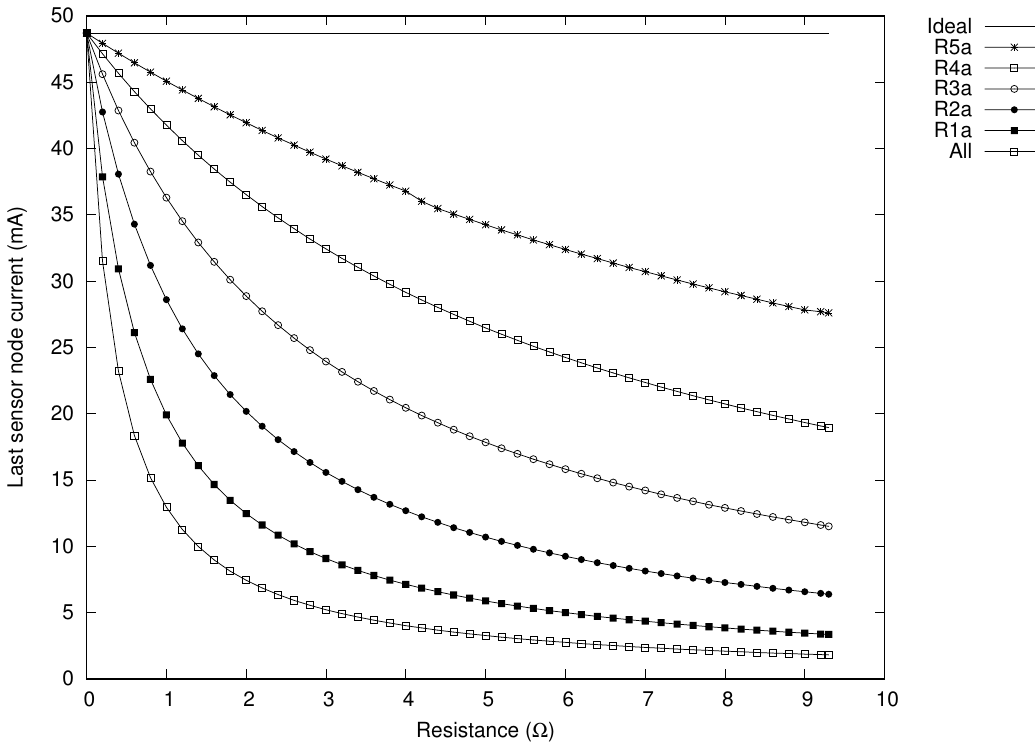
Figure 6. Simulation results of the last sensor node current dependency for a five stages network